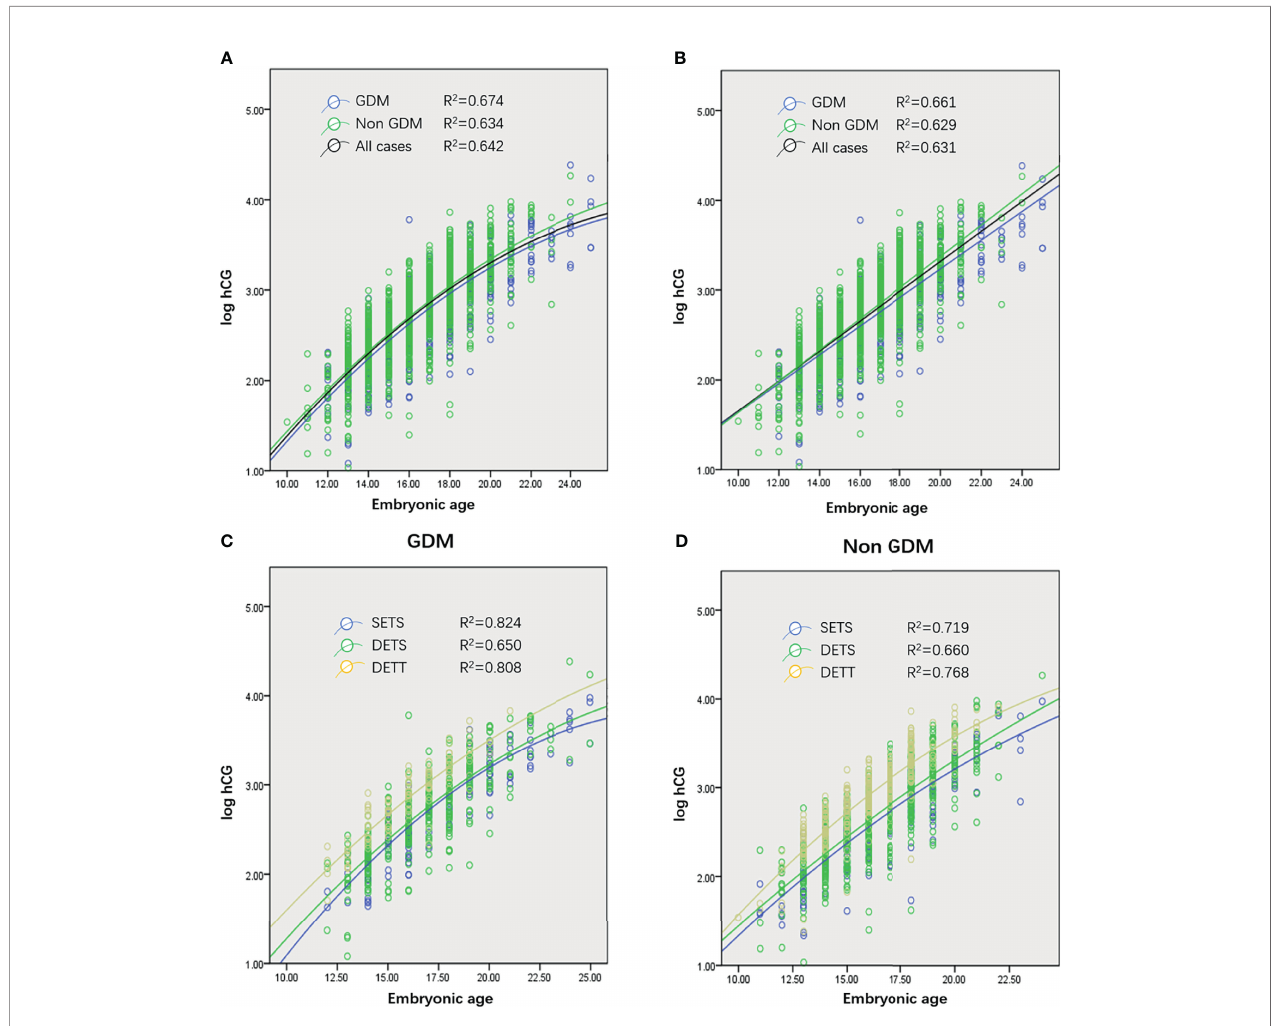
FIGURE 1 | (A, B) Quadratic curves (A) and linear plot (B) generated from serial log human chorionic gonadotropin (hCG) concentrations of women who conceived through in vitro fertilization (IVF) and ultimately achieved live births from all cases (1,005 patients, 1,839 observations), gestational diabetes mellitus (GDM) cases (305 patients, 604 observations), and non-GDM cases (700 patients, 1,235 observations). (C, D) Curves generated from single embryo transfer and singleton pregnancy (SETS; 196 patients, 394 observations), two embryo transfers and singleton pregnancy (TETS; 542 patients, 980 observations), and two embryo transfers and twin pregnancy (TETT; 261 patients, 447 observations) cases in GDM (C) and non-GDM (D) groups. No curve of single embryo transfer and twin pregnancy was generated because only 9 patients were recruited in the present